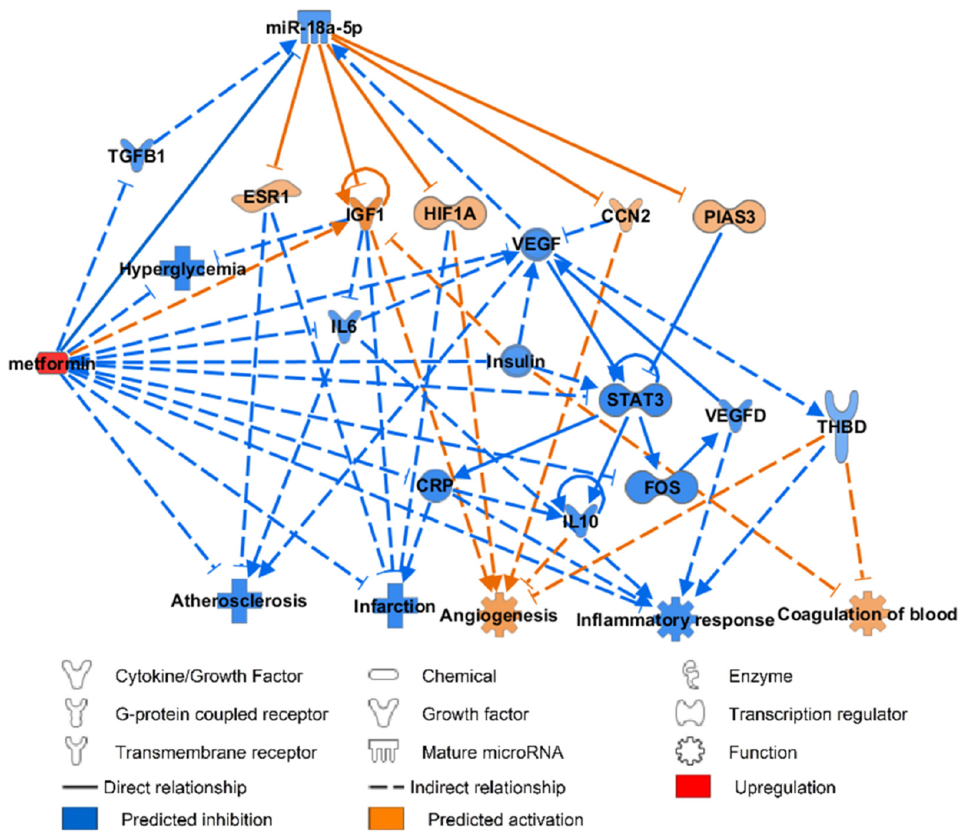
Figure 6. IPA prediction network of miR-18a-5p molecular targets and functional pathways following metformin intervention. CCN2 : communication network factor 2; CRP : C − reactive protein; ESR : estrogen receptor 1; FOS : Fos proto-oncogene; HIF-1 α : hypoxia inducible factor-1 subunit alpha; IGF1 : insulin-like growth factor 1; IL : interleukin; PI AS3: protein inhibitor of activated STAT 3; TGF β 1 : transforming growth factor beta 1; THBD : thrombomodulin; VEGF : vascular endothelial growth factor.